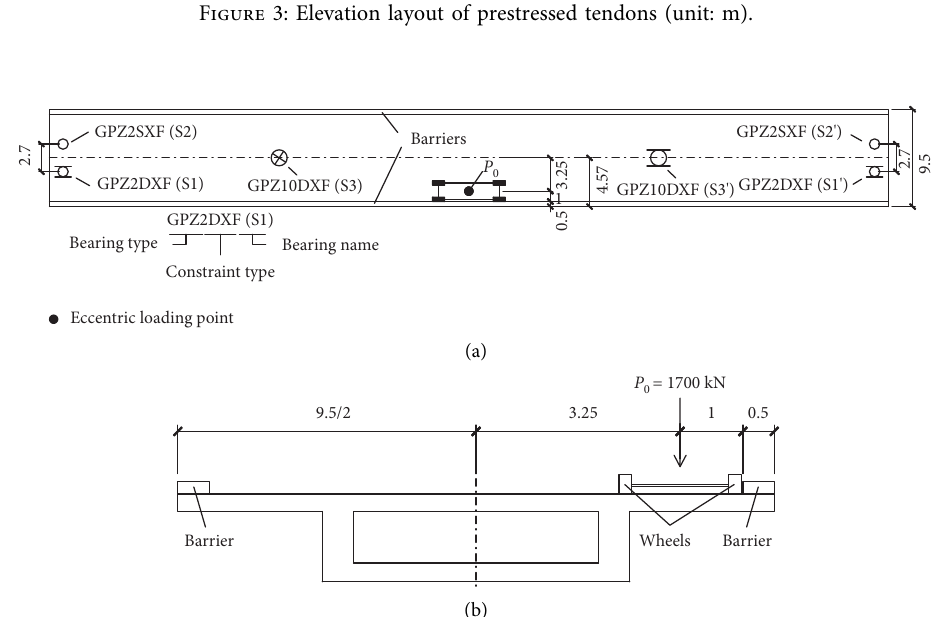
Figure 4: Layout of bearings and position of eccentric load P